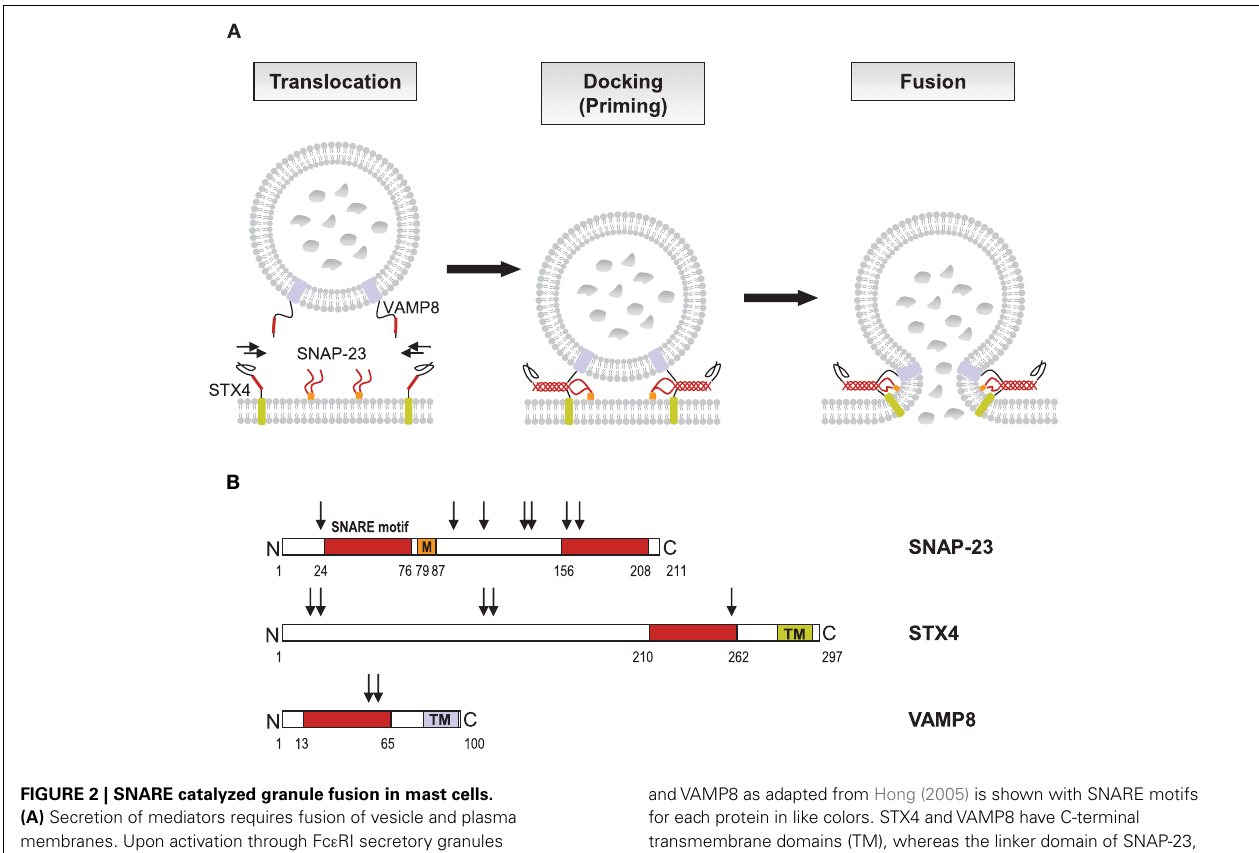
FIGURE 2 | SNARE catalyzed granule fusion in mast cells. (A) Secretion of mediators requires fusion of vesicle and plasma membranes. Upon activation through Fc ε RI secretory granules translocate to and dock at the plasma membrane where the t-SNAREs SNAP-23 and STX4 together with the v-SNAREVAMP8 form stable tetrameric complexes of bundled helices bringing the lipid bilayers into a close distance to catalyze membrane fusion.The SNARE motifs of SNAP-23, STX4, andVAMP8, which become highly organized in the four helical bundle during the formation of the trans-SNARE complex are highlighted in color. (B) The primary structure of human SNAP-23, STX4,